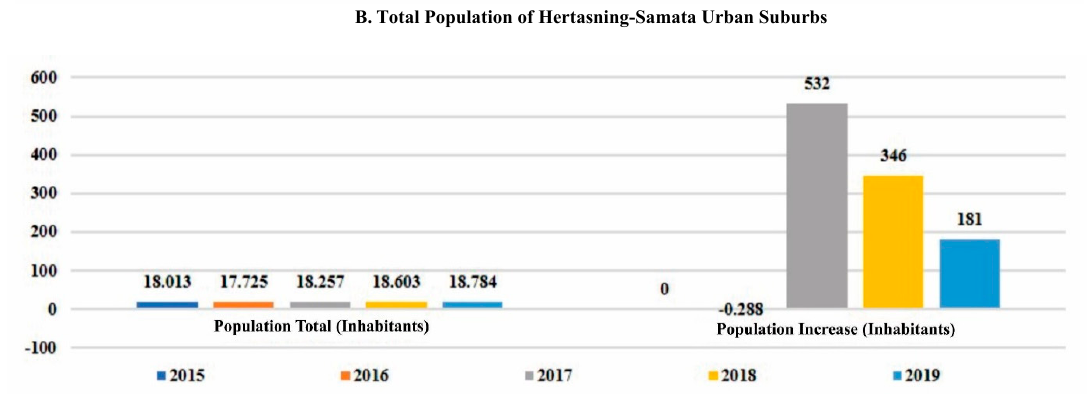
Figure 5. A, B, and C. The Development of the Population of Mamminasata Metropolitan Urban Figure 5. ( A – C ). The Development of the Population of Mamminasata Metropolitan Urban Suburbs. Suburbs. Source: author elaboration, input: reference [90]. Source: author elaboration, input: reference